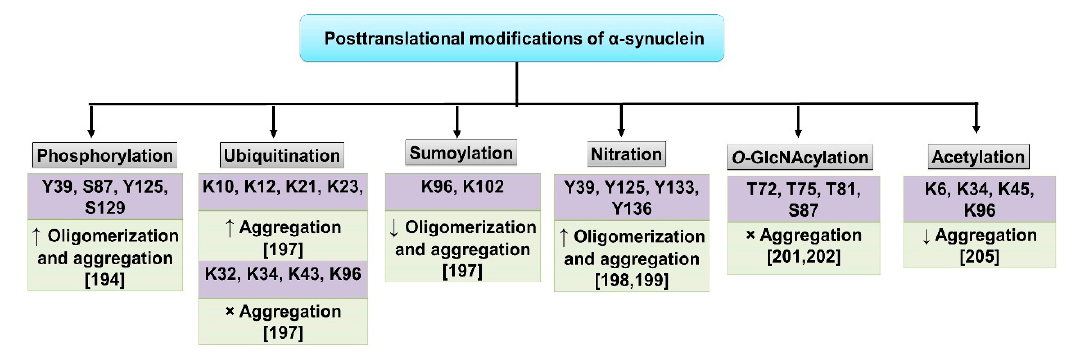
Figure 1. α -synuclein folding, oligomerization and aggregation: SNCA gene on chromosome 4 encodes for the protein α -synuclein. Two truncated forms of the proteins of 126aa and 112aa are also found in the brain together with the full length. The structure of the protein comprises of three distinct domains: amphipathic N-terminus (1–60 residues), a central NAC region (61–95 residues) and the C-terminus region (96–140) [192]. A role for α -synuclein in the membrane curvature and interaction with the SNARE complex and, therefore, in synaptic vesicular trafficking and the release of dopamine have been reported [193]. Two important facets of α -synuclein proteostasis involve chaperone-dependent regulation of protein folding and degradation of the misfolded protein. α -synuclein monomers interact and form a stable homotetrameric structure under physiological conditions [194], whereas in pathological conditions, upon misfolding, the monomer is converted into β -sheet rich oligomers or prefibrills. The oligomers ultimately change into highly ordered fibrils which subsequently form LBs [16]. Chaperone-aided fragmentation of the fibrils and disaggregation have also been reported [39]. Degradation of the misfolded protein can occur by three different mechanisms: proteasome-assisted UPS (Ubiquitin Proteasome System), chaperone-mediated autophagy (CMA; Lamp2A mediated) and macroautophagy, both dependent on lysosome [10]. Several chaperones and co-chaperones are identified that modulate various stages of proteostasis of α -synuclein (listed in the boxes). The red line indicates inhibition.